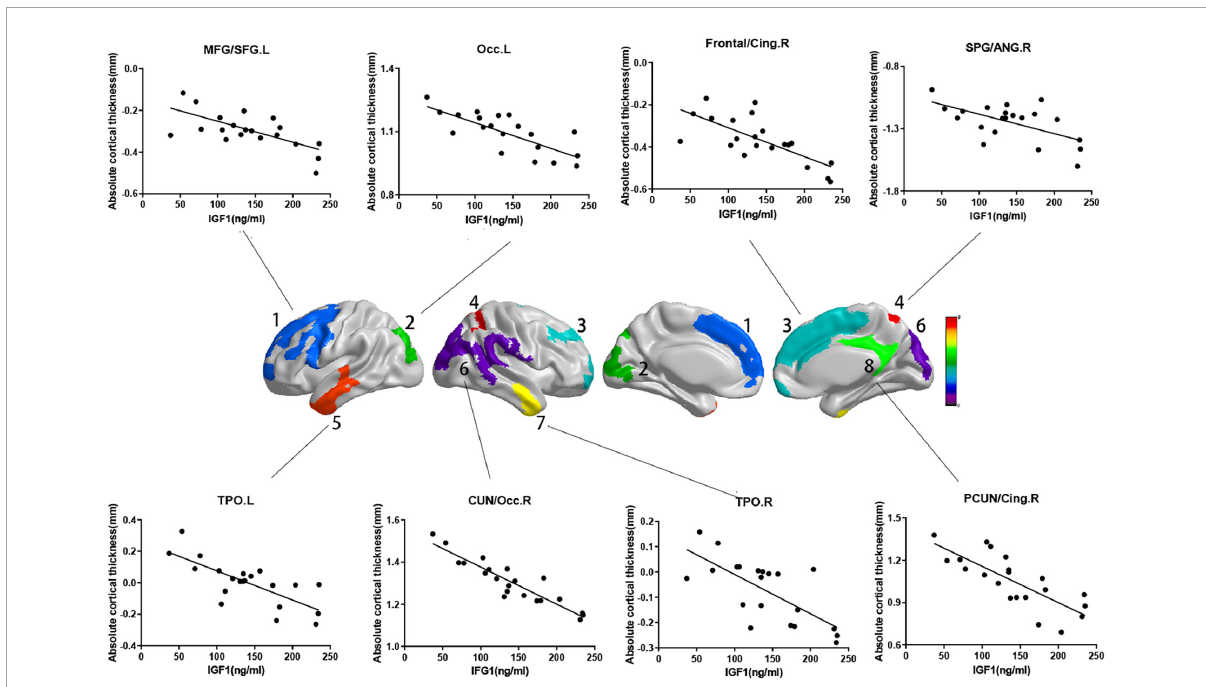
FIGURE1 Correlations between absolute cortical thickness and serum IGF-1 levels in specific regions. Regions with P < 0.05 are shown. Absolute cortical thickness of above regions were negatively correlated with serum IGF-1 levels after adjusted for age, gender and group. (a) MFG/SFG.L: r = –0.687, P = 0.002; (b) Occ.L: r = –0.746, P < 0.001; (c) frontal/cing.R: r = –0.692, P = 0.001; (d) SPG/ANG.R: r = –0.680, P = 0.002; (e) TPO.L: r = –0.741, P < 0.001; (f) CUN/Occ.R: r = –0.864, P < 0.001; (g) TPO.R: r = –0.710, P = 0.001; (h) PCUN/Cing.R: r = –0.704, P = 0.001. IGF-1, insulin-like growth factor-1; MFG, middle frontal gyrus; SFG, superior frontal gyrus; Occ, occipital lobe; Frontal, frontal lobe; Cing, cingulum; SPG, superior parietal gyrus; ANG, angular gyrus; TPO, temporal lobe; CUN, cuneus; PCUN, precuneus; L, left; R,